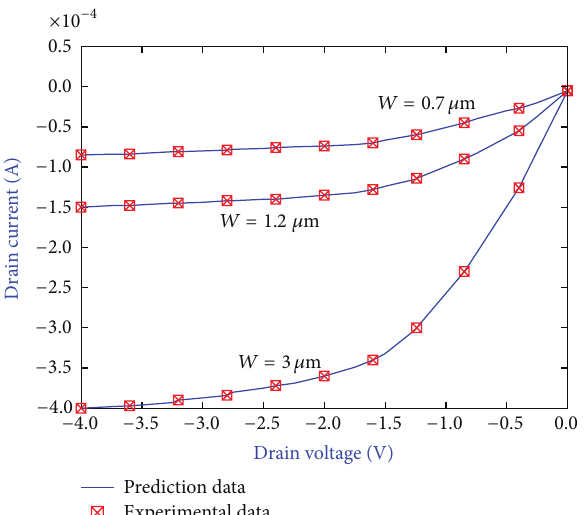
Figure 14: Comparison of 𝐼 𝑑 measured results and prediction data of the group 2B diagnostic samples (as 𝑊 = 0.7 , 1.2, 3- 𝜇 m, 𝑉 𝑔 = −3 V).